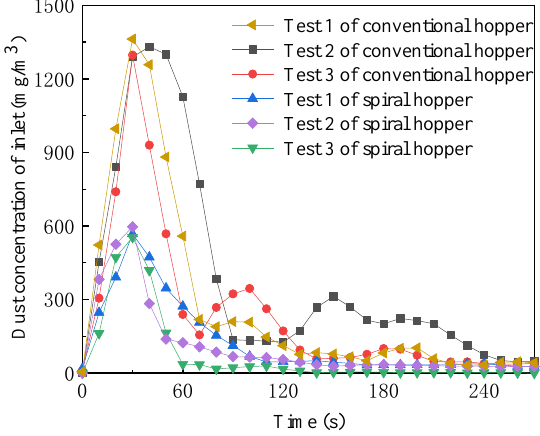
Figure 8. Dust concentration of hopper inlet at different times.